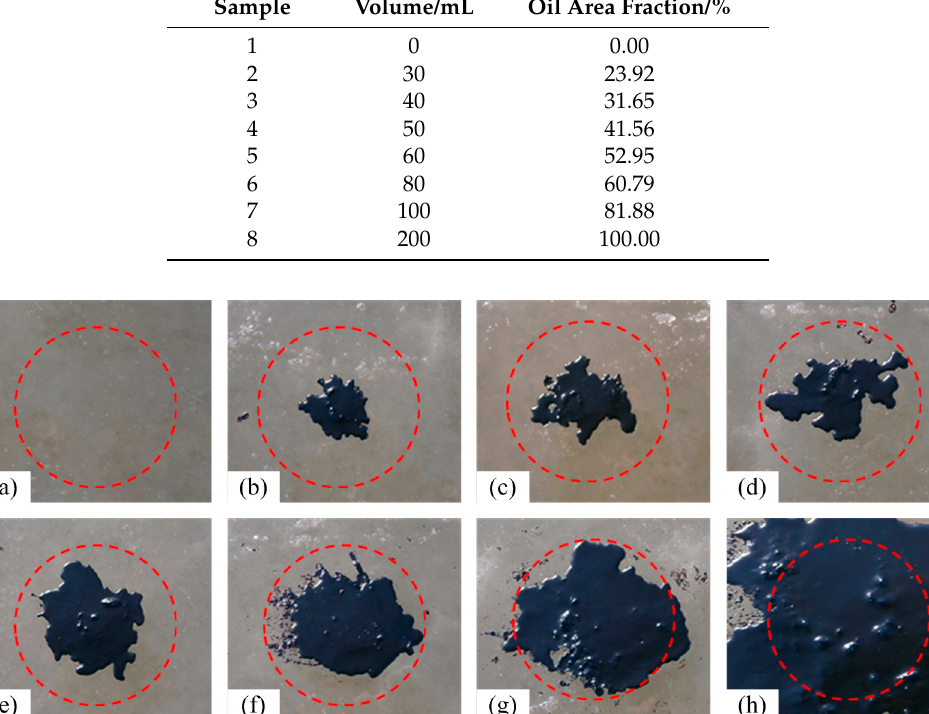
Figure 1. Schematic of oil pollution (the red circle represents the observation range of the spectrometer probe). ( a ) is the non-polluted sea ice; the proportion of the oil-polluted area in ( b – h ) is 23.92%, 31.65%, 41.56%, 52.95%, 60.79%, 81.88% and 100.00% respectively.